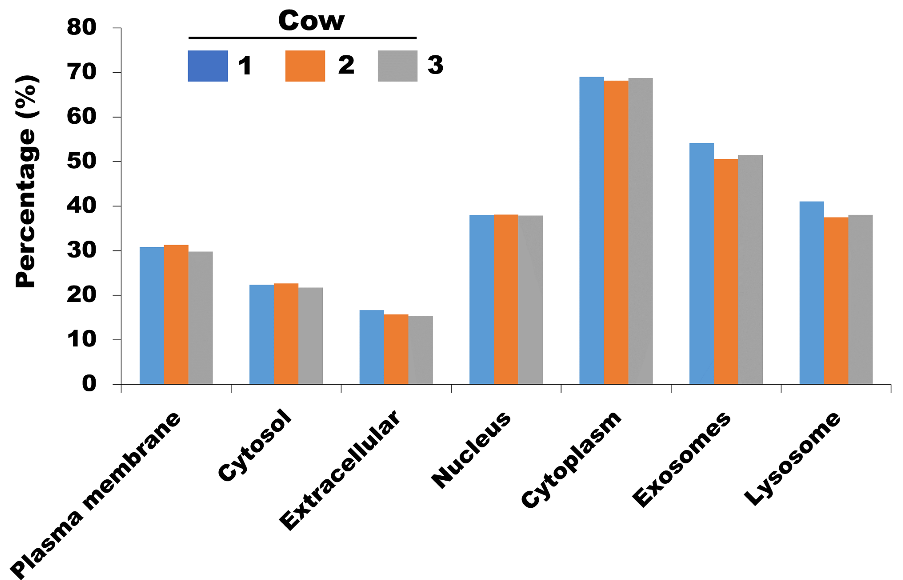
Figure 4. The comparative cellular component of identified proteins in milk sEVs.